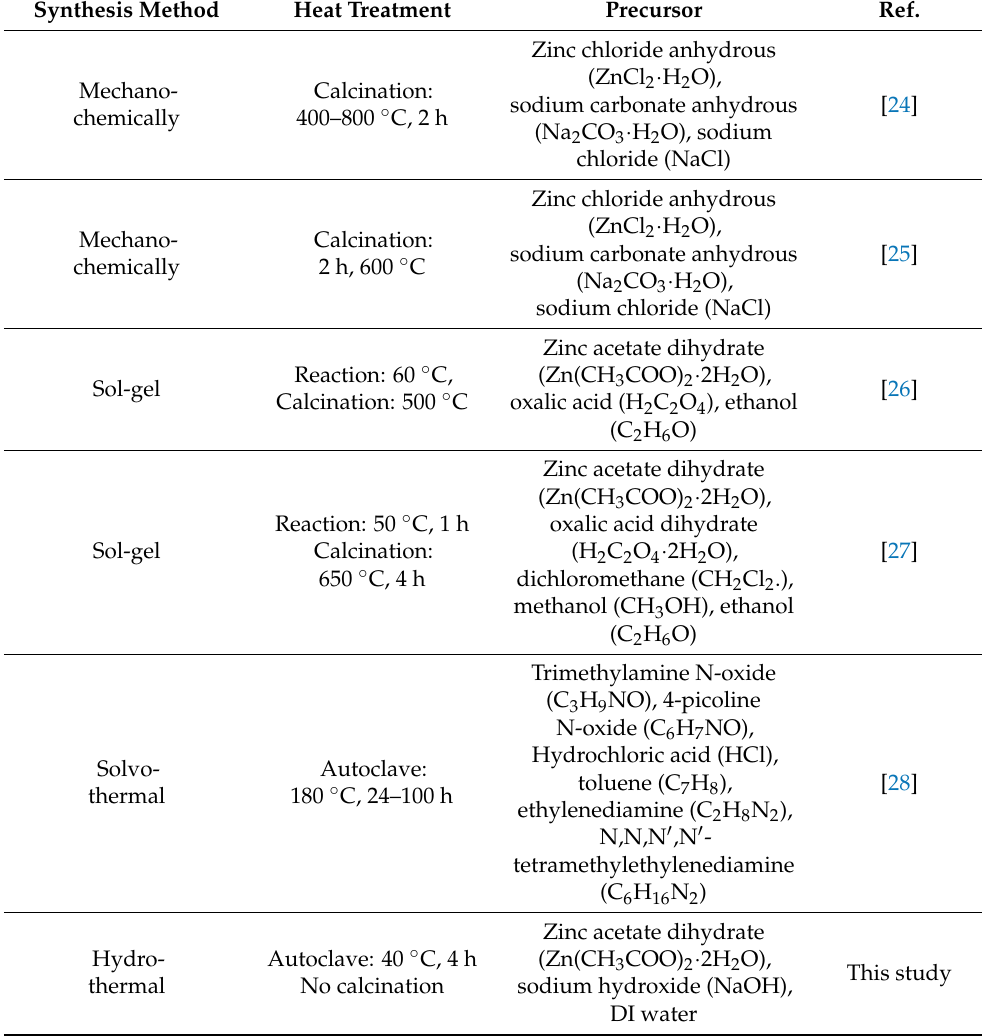
Table 1. Methods and conditions reported in the literature for the synthesis of ZnO. Synthesis